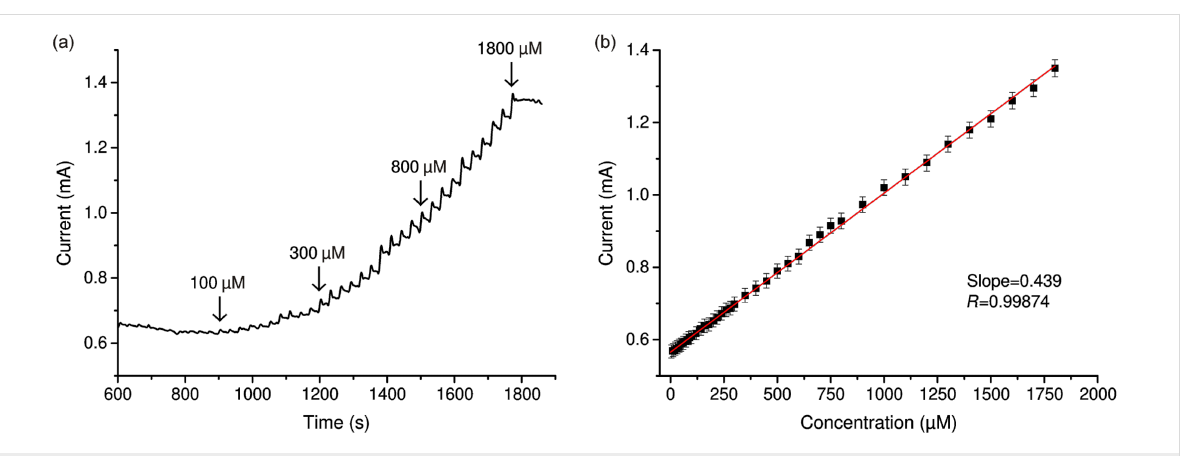
Figure 6: (a) Amperometric response of the nanostructured CuO electrode in 0.1 M NaOH with stepwise addition of H 2 O 2 at concentrations from 10 to 1800 μ M and (b) the corresponding calibration curve (SD = 3.5%, n = 5).